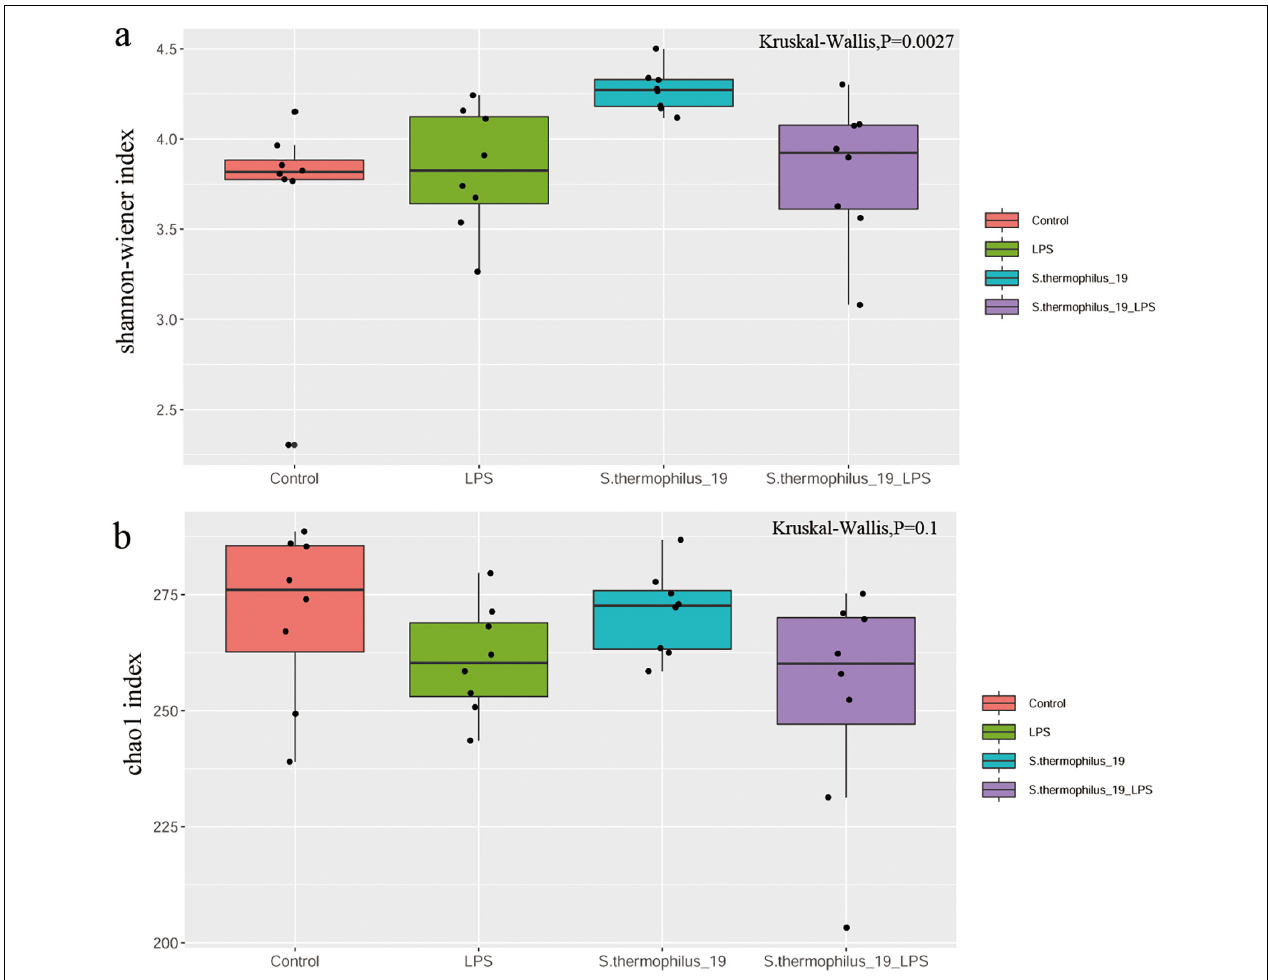
FIGURE 4 | LPS induces significant impact on microbiota composition. (A) Shannon index. (B) Chao1 index. ( n =